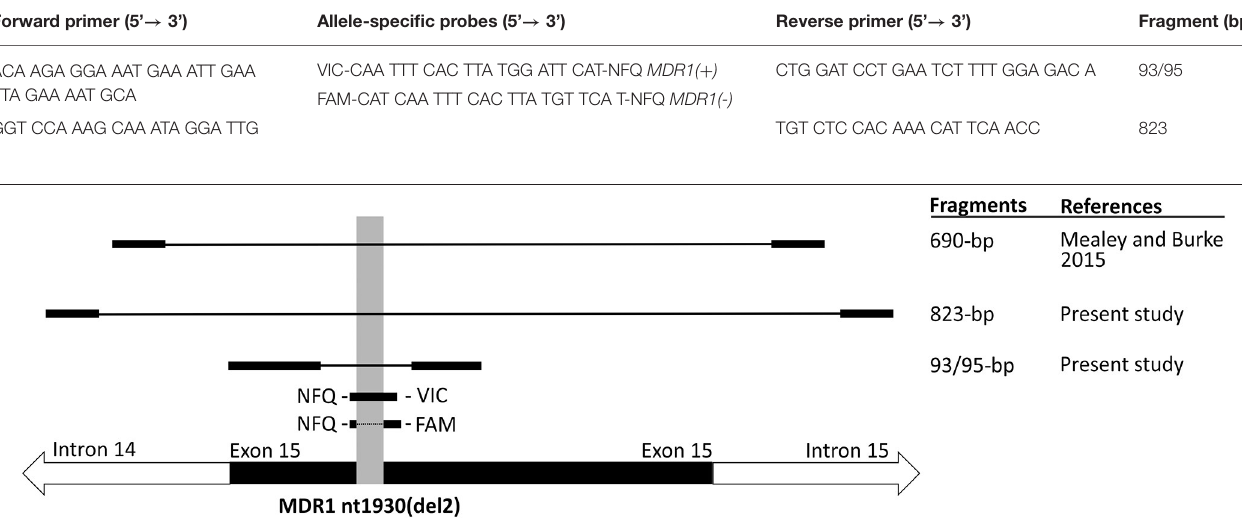
FIGURE 1 | Schematic overview of the localization of the primer and probe sequences used for cat MDR1 genotyping. For comparison, localization of the primers used for cat MDR1 genotyping in the previous study by Mealey and Burke (13) is indicated. Localization of the ABCB1 1930_1931del TC mutation (syn. MDR1 nt1930(del2)) is indicated by